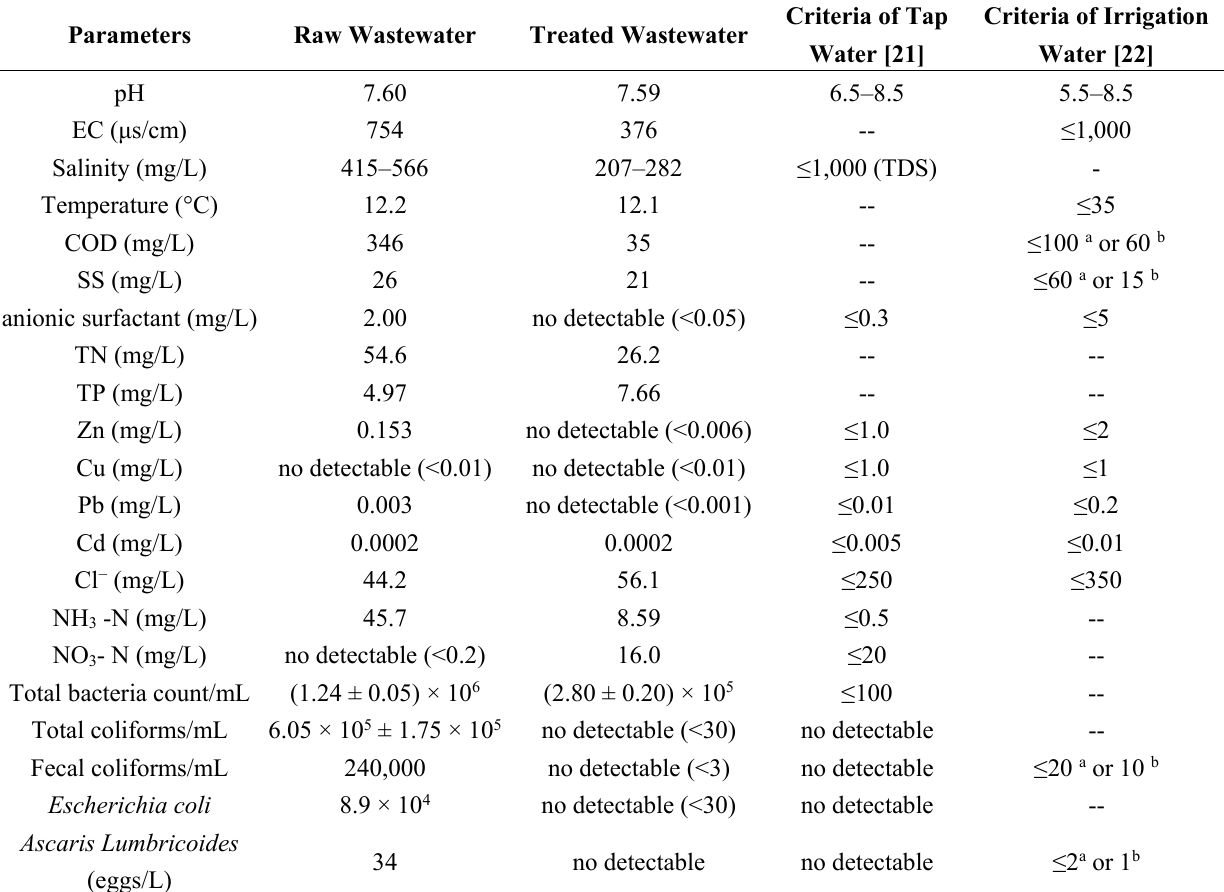
Figure 1. Process flow diagram of the wastewater treatment system with a membrane bioreactor. Table 2. Physical and chemical properties of experimental water